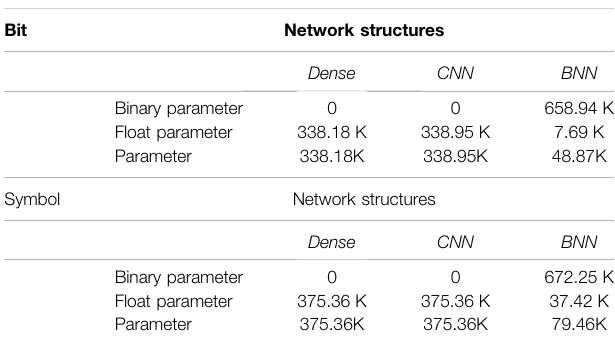
TABLE 1 | Parameter size being updated in networks.